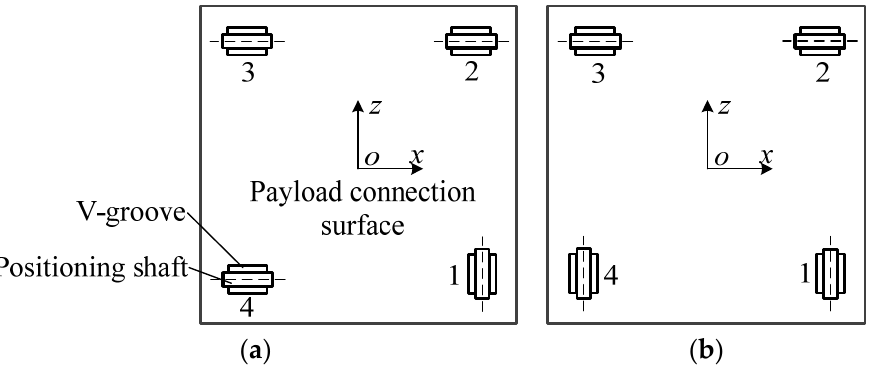
Figure 4. Schematic diagram of a circular shaft-V-groove positioning arrangement. ( a ) Three-one orthogonal arrangement diagram; ( b ) two-two orthogonal arrangement diagram. Table 2. Three positioning methods to evaluate the key parameters of the model.